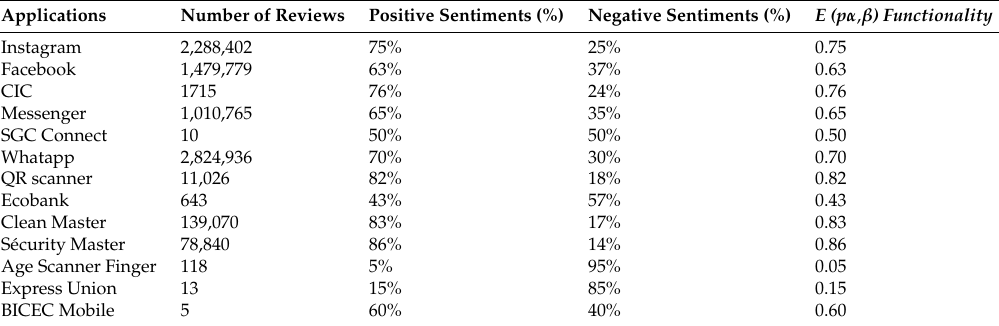
Table 6. Reputation in terms of functionality.